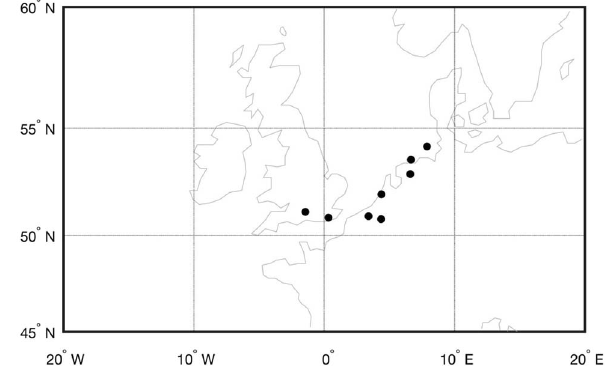
Fig. 13. Map showing the locations of the GNSS stations